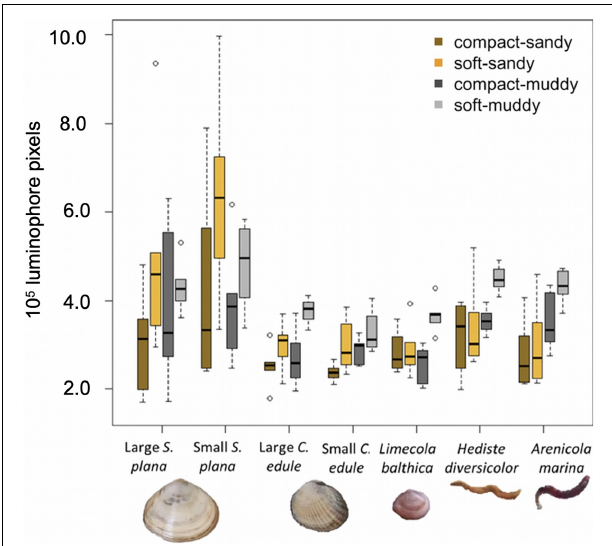
FIGURE 7 | Boxplots showing luminophore dispersal, i.e., the integral of luminophore profiles over depth (see Figure 8 for average profiles), by species and sediment treatment, where the box (25–75% of the data) contains a black line (median) and has whiskers extending to the minimum and maximum data values, with outliers as open circles. All species transported more luminophores in soft vs. compact sediment and polychaetes also transported more luminophores in muddy vs. sandy sediment. The area has been corrected for the average control values (compact-sandy: –0.31 × 10 5 luminophore pixels, soft-sandy: –0.44 × 10 5 luminophore pixels, compact-muddy: +0.23 × 10 5 luminophore pixels, soft-muddy: +0.39 × 10 5 luminophore